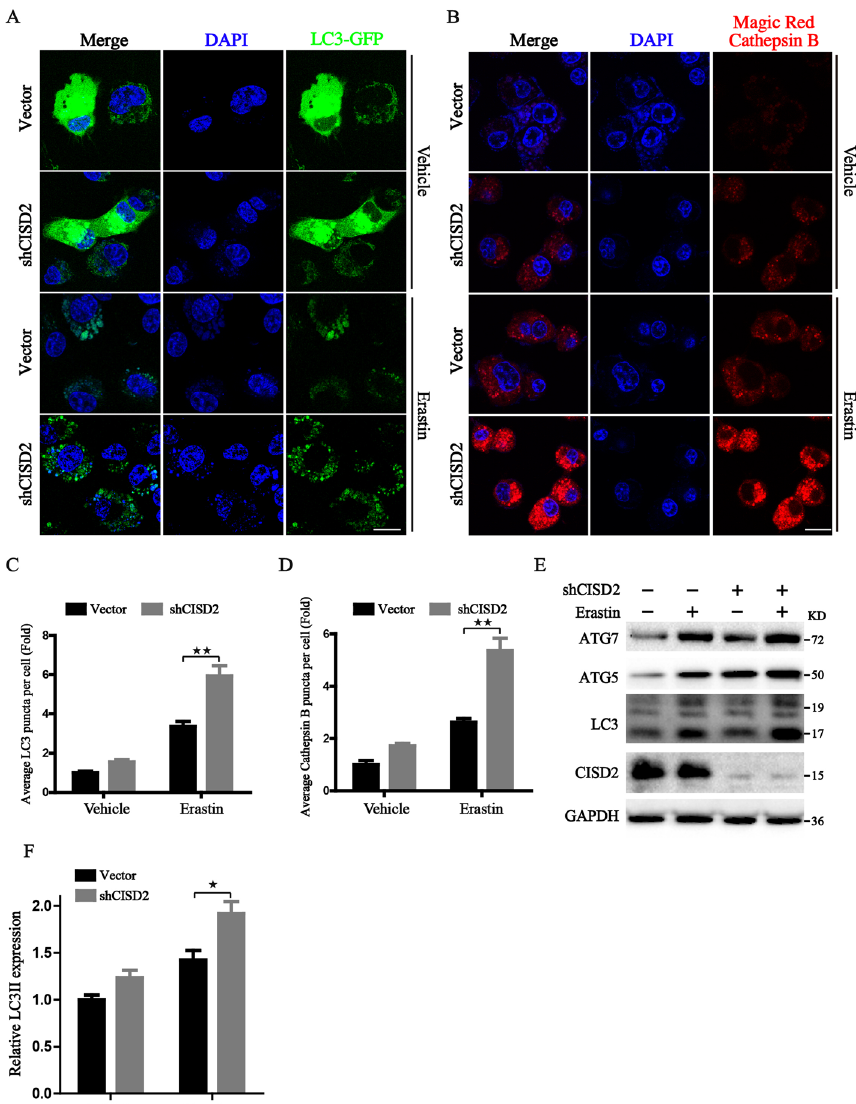
Fig. 2 CISD2 knockdown promotes the activation of autophagy. A Representative images of the LC3 punches formation by confocal microscope in HT-1080 cells transfected with LC3-GFP adenovirus with or without Erastin (7.5 µM) treatment for 2 h. Scale bar: 10 μm. B Detection of the activity of lysosome by Magic Red cathepsin B staining and confocal microscopy. The intensity of red fluorescence was positively correlated with the lysosomal activity. Scale bar: 10 μm. C , D Statistical graph of LC3-GFP and cathepsin B staining, respectively ( n 3). E Western blot analysis of the expression of proteins associated with autophagy; GAPDH = was used as loading control. F Quantitative analysis of LC3 expression; ★★ P < 0.01 between the indicated